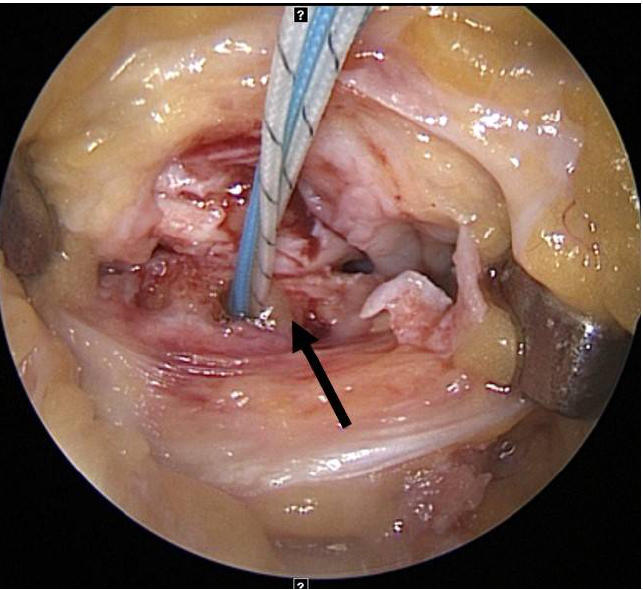
Figure 2. All-soft suture anchor is inserted slightly anterior to the midbody level of the lateral meniscus.